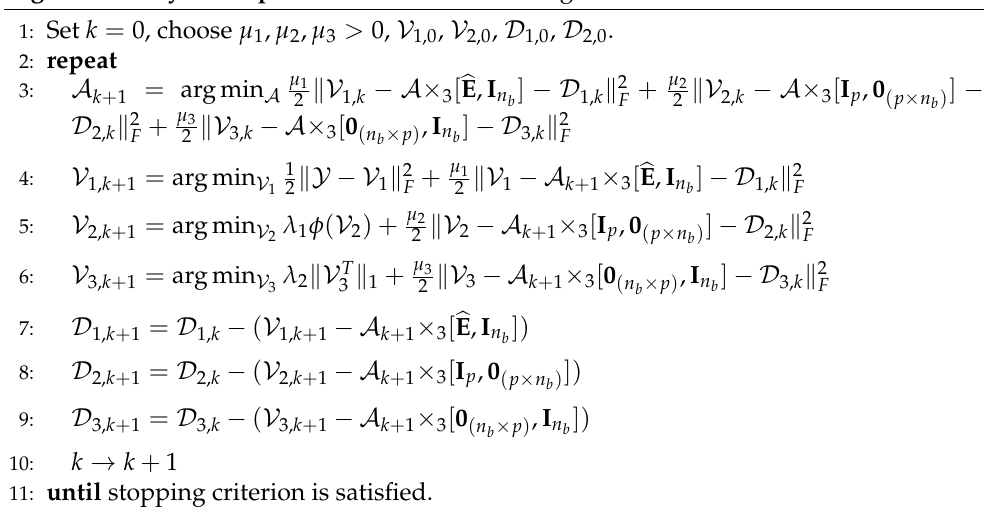
Algorithm 1 HySuDeep for mixed noise containing i.i.d. Gaussian